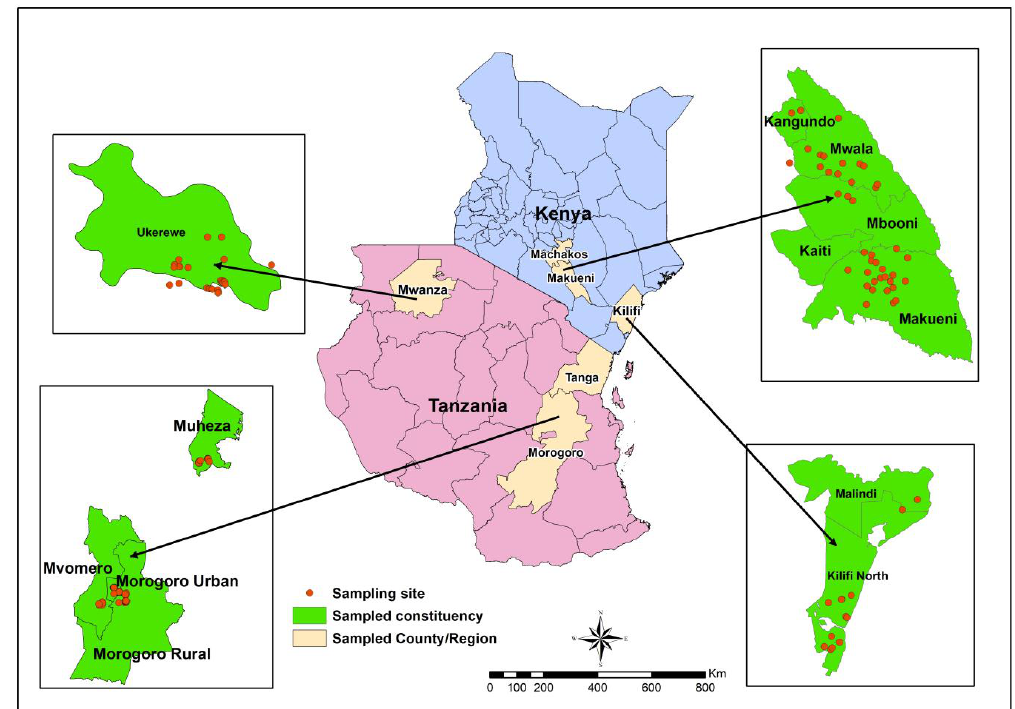
Figure 1. Study sites within Machakos, Makueni and Kilifi in Kenya, Mwanza, Morogoro and Tanga in Tanzania.